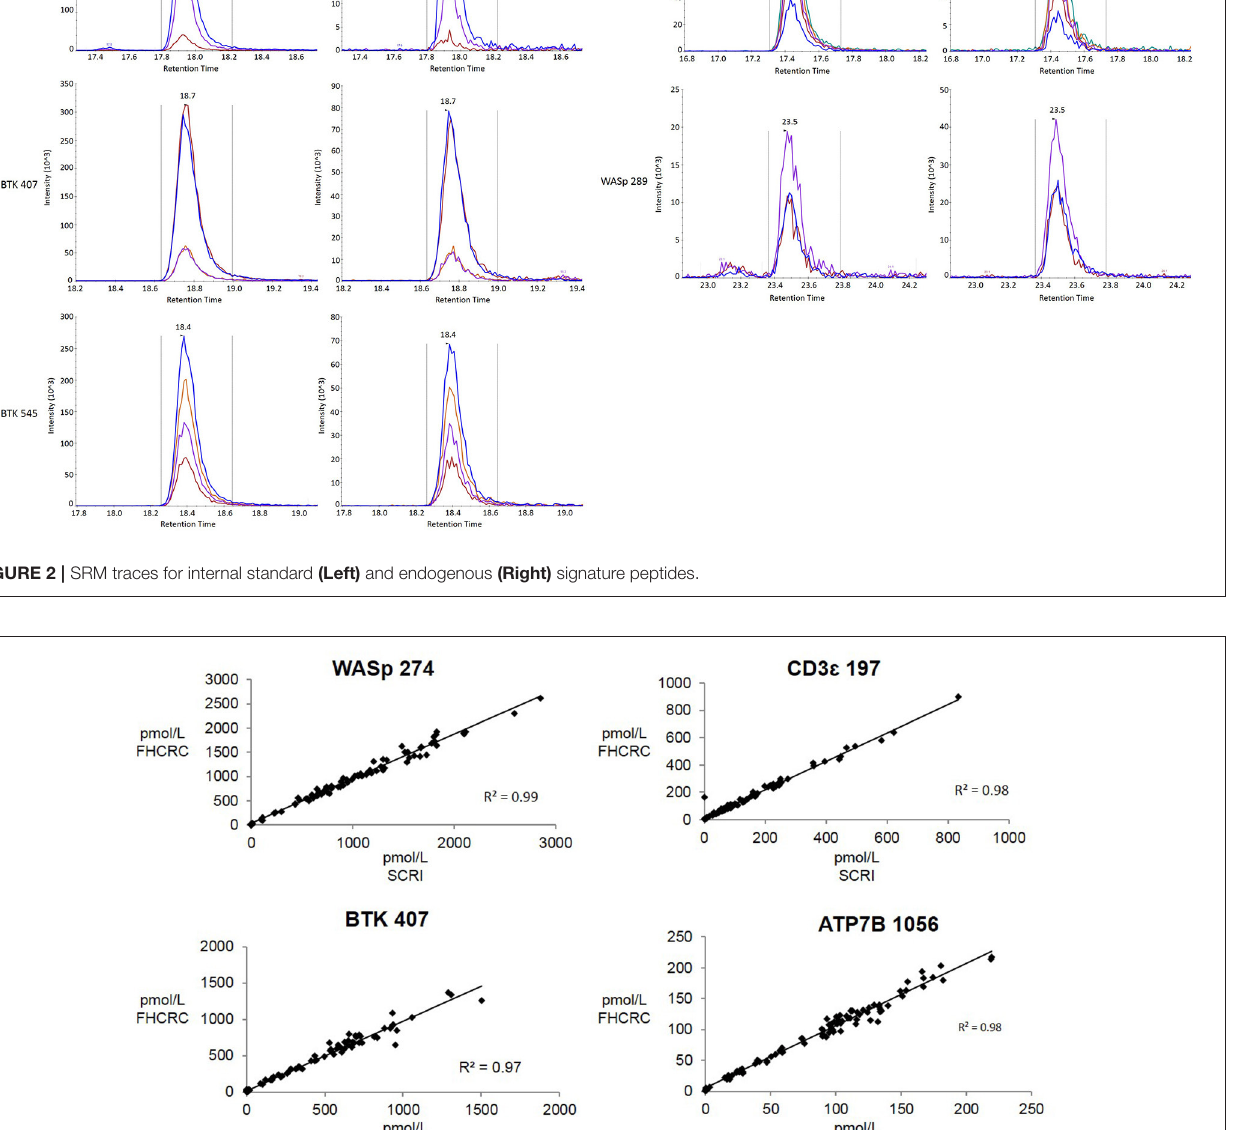
significant ( p < 0.05–0.0001) reductions in patient peptide levels relative to control groups in each case ( Figure 5 ). Peptide levels in the majority of affected patients were significantly diminished or absent ( Table 4 ). For each patient, the concentration of ATP7B 1056 was also